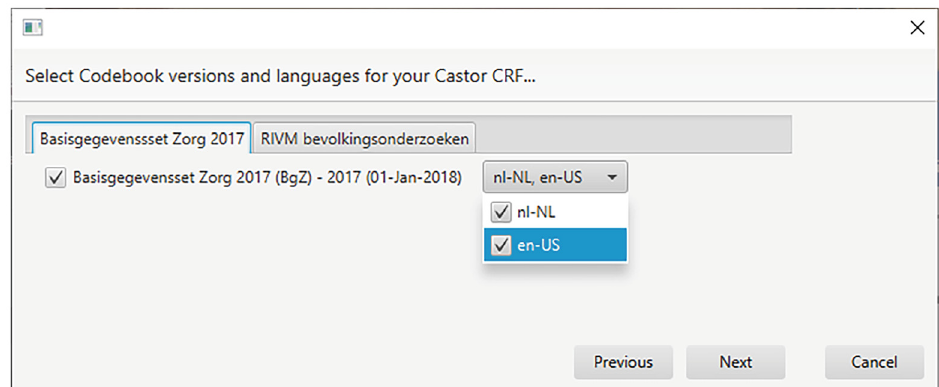
Figure 4. User selects codebook version(s) and language(s).